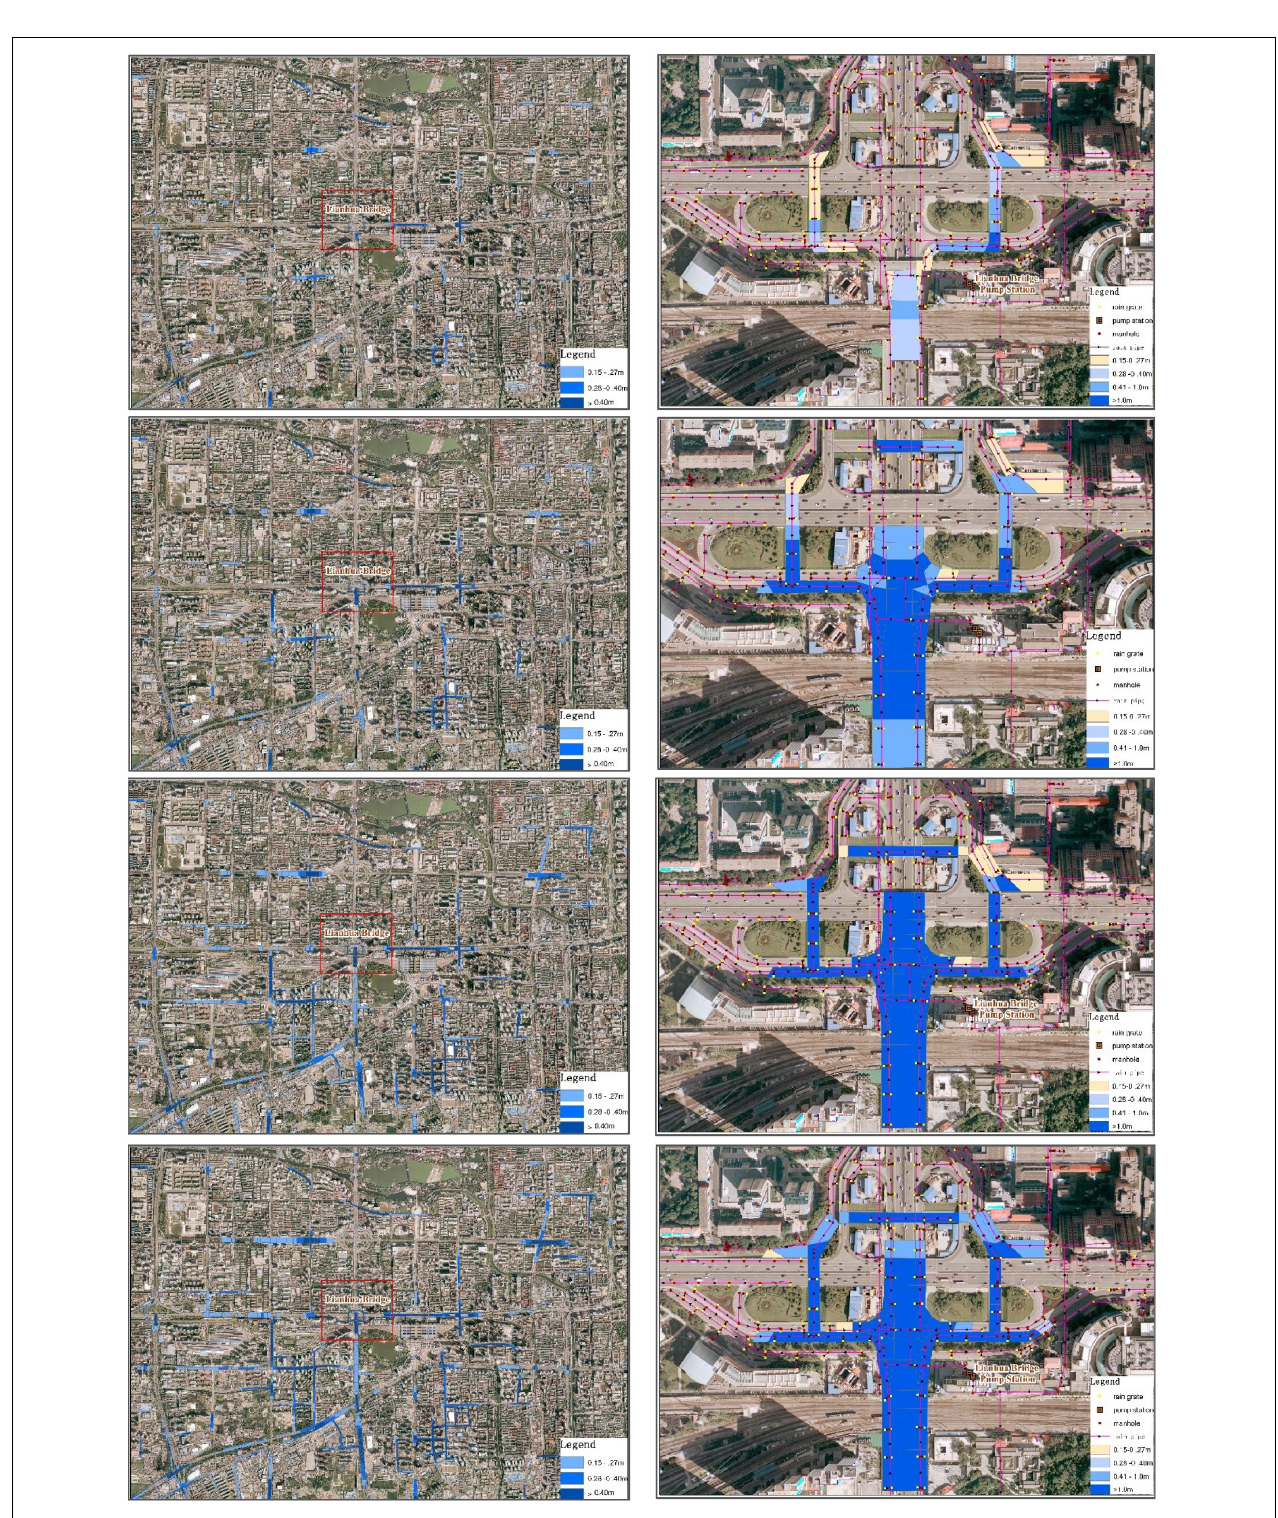
FIGURE 6 | Waterlogging simulationg result of 10, 20, 50, and 100 year recurrence intervals.